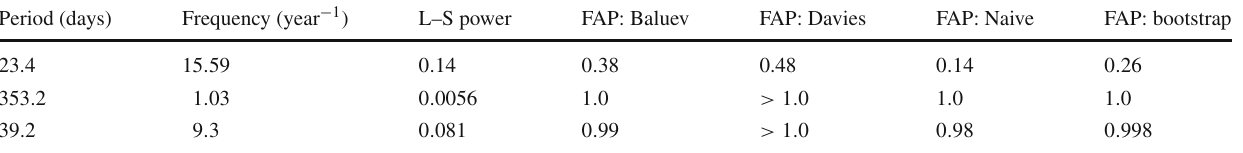
Table2 123 I L–SpowersandFAPforourdatausingmultiplemethods: Baluev, Davies, Naive, and bootstrap. Similar to Table 1, we find the corresponding values for the period and frequency of the most signifi- cant peak (corresponding to the period of 23.39 days), followed by the period closest to the annual variation (365 days), as well as the period